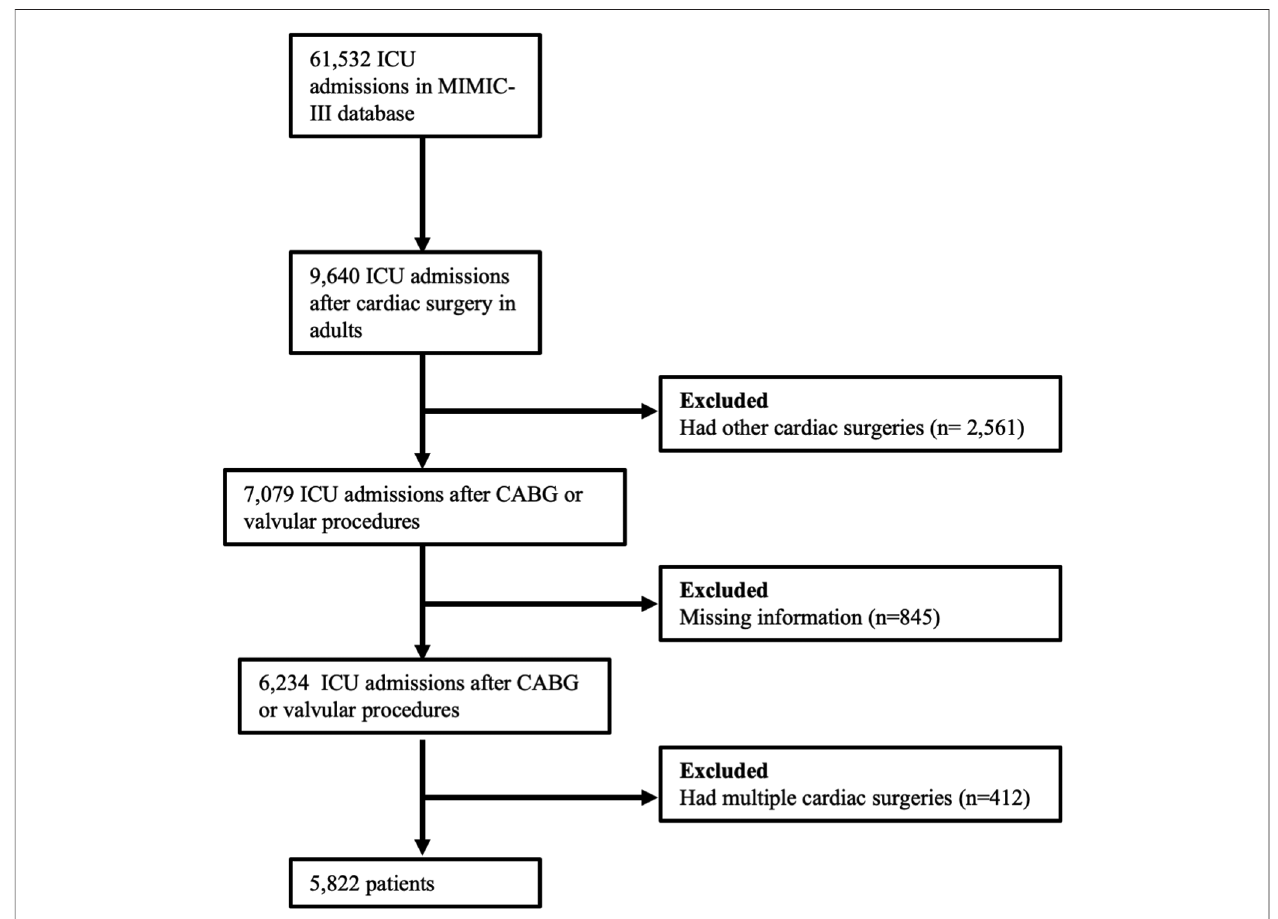
FIGURE 1 | Study cohort inclusion and exclusion fl ow